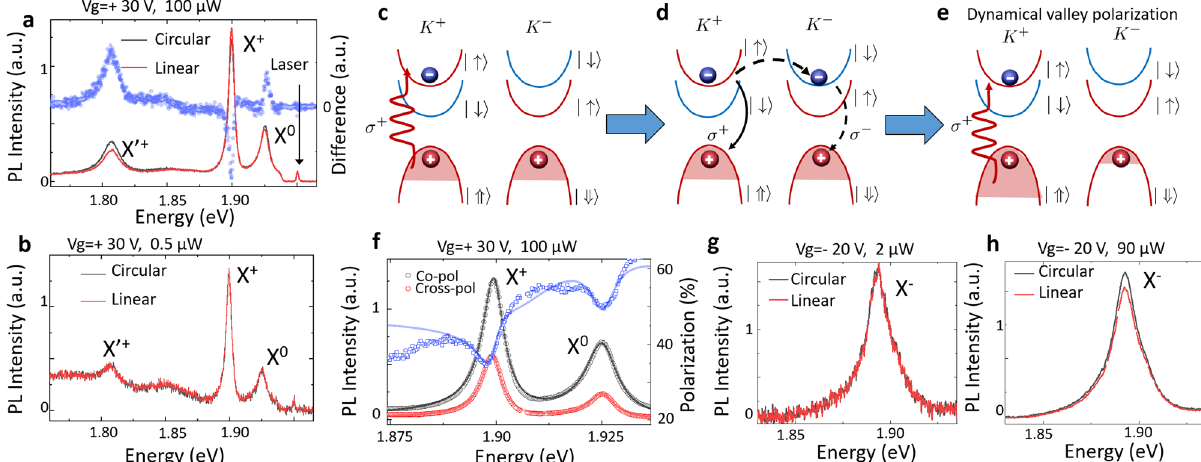
Fig. 5 Optically-induced dynamical polarization of resident carriers in monolayer MoS 2 . a Total photoluminescence (PL) intensity under circular (black) and linear (red) excitation in the p-type regime (gate bias voltage V g = + 30 V) at an excitation power of 100 μ W. Also shown in blue dots the difference between these two curves. b Same as in ( a ) at a small excitation power of 2 μ W. (c) Formation of a positively-charged trion in the K + valley following right- handed circular polarization. d A trion in the K + can either recombine radiatively or scatter to the opposite valley before recombination. e In steady state, the process ( c , d ) will lead to a spin and valley-polarization of the valence band. f Polarized PL emission under circular excitation and degree of circular polarization (blue dots). Co-pol and cross-pol denote the co-polarized and cross-polarized compontents of the PL with respect to the laser, respectively. g Total PL intensity under circular (black) and linear (red) excitation in the n-type regime (gate bias voltage V g = − 20 V) for an excitation power of 2 μ W. h Same as ( g ) for an excitation power of 90 μ